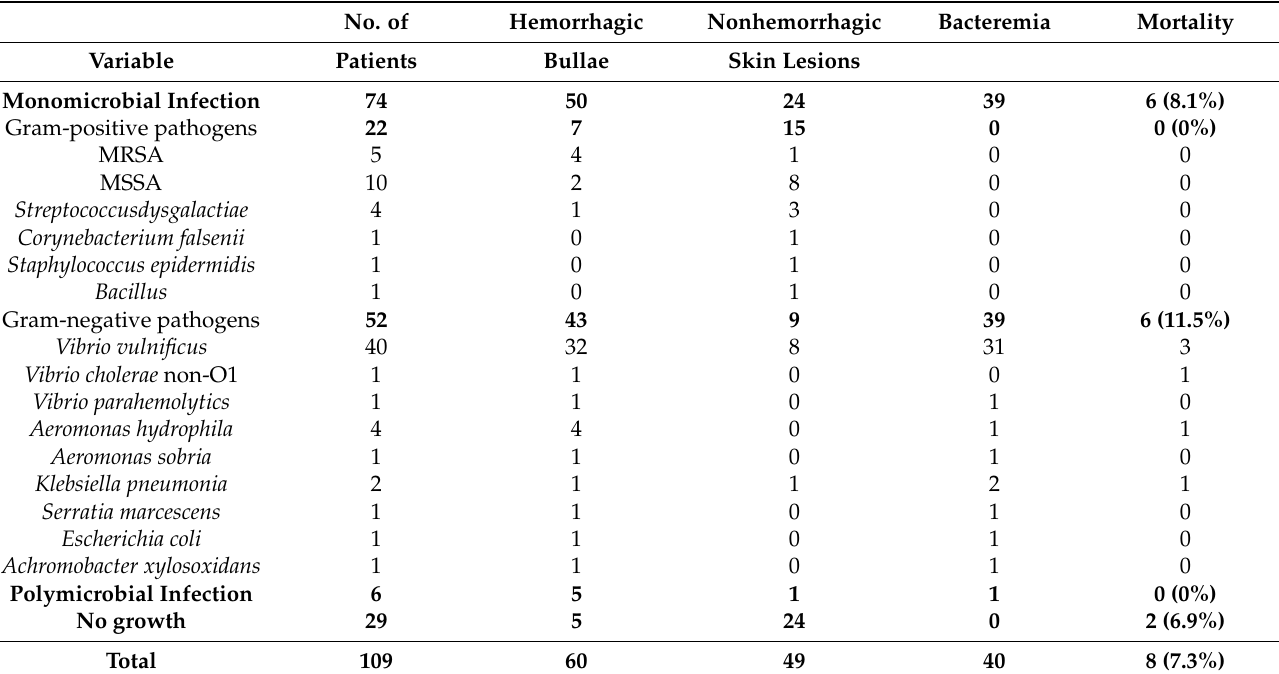
Table 1. Mortality and microbiology in patients with necrotizing fasciitis. No. of